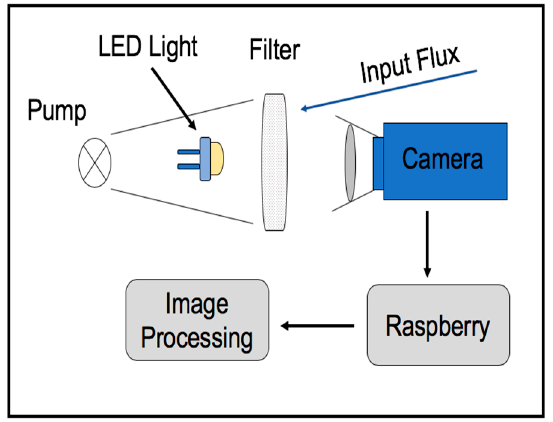
Figure 11. The structure of the filter-based sensing